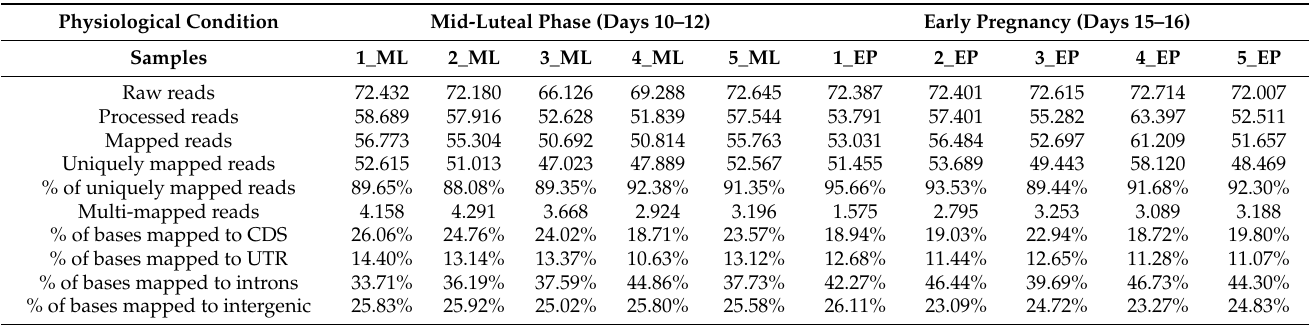
Table 1. Summary of the RNA-Seq results and the initial stages of in silico analyses—the raw reads processing and mapping them to the porcine reference genome ( S. scrofa ver. 11.1.104). Numerical values are expressed in